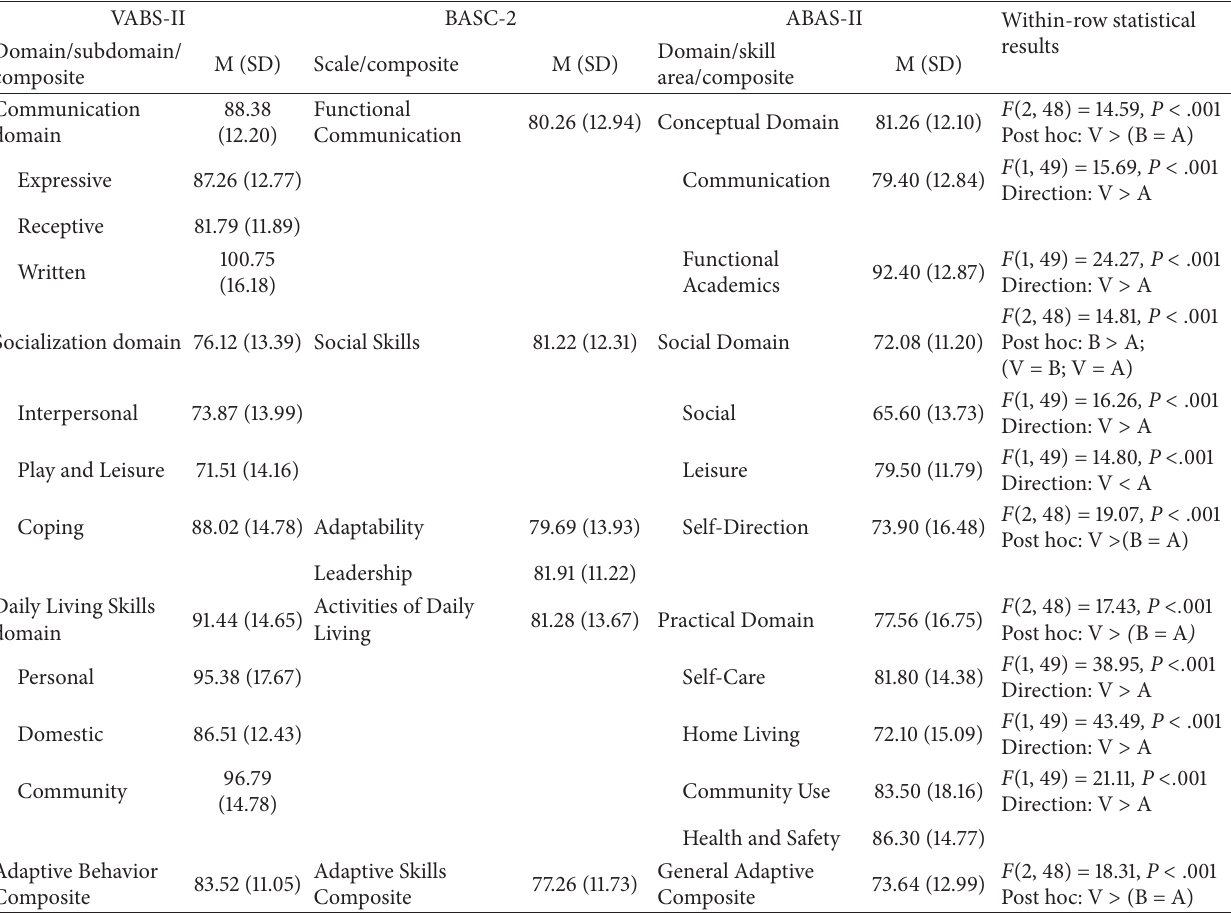
Table 3: Cross-measure comparisons of the VABS-II, BASC-2 PRS, and ABAS-II scores assessing similar